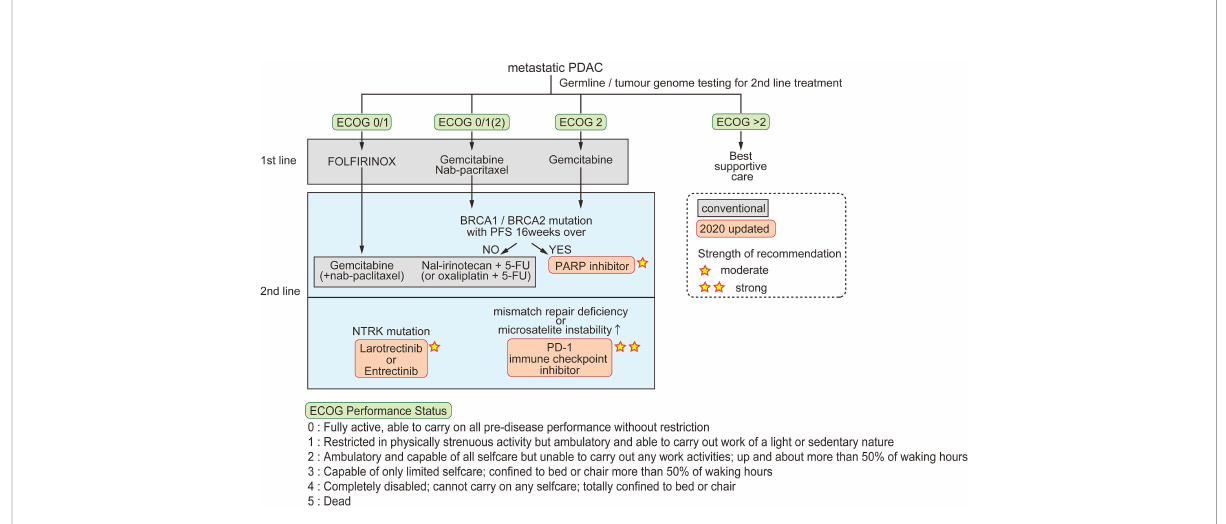
FIGURE 1 Conventional and updated guidelines for metastatic PDAC. Patients are classi fi ed by ECOG performance status for fi rst-line chemotherapy. For second-line therapy, three options are recommended in the 2020 updated guidelines. The strength of recommendation is indicated by the number of